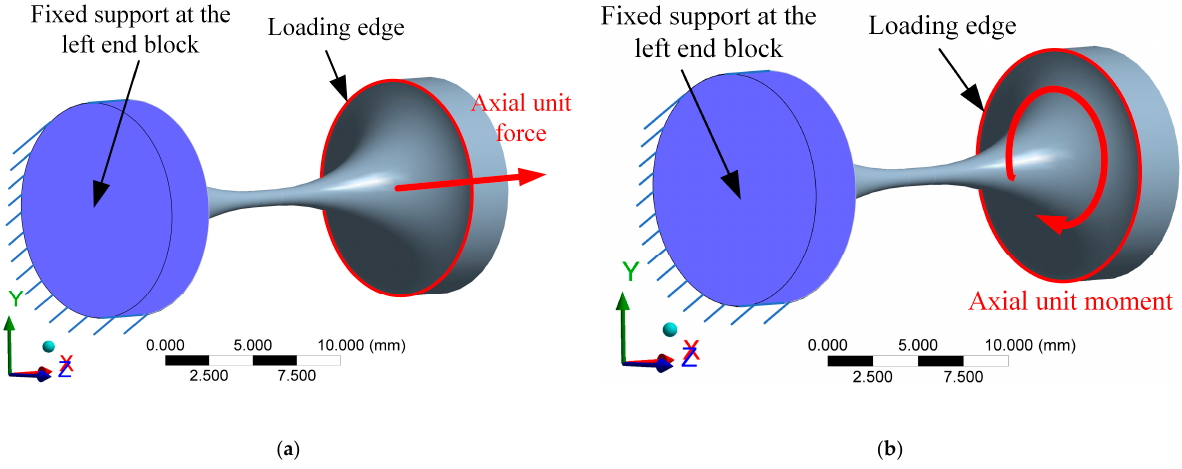
Figure 5. The constraint and load settings in the FEA: ( a ) Fixed support at the left end block and unit force applied onto the right end edge; ( b ) Fixed support at the left end block and unit moment applied onto the right end edge.